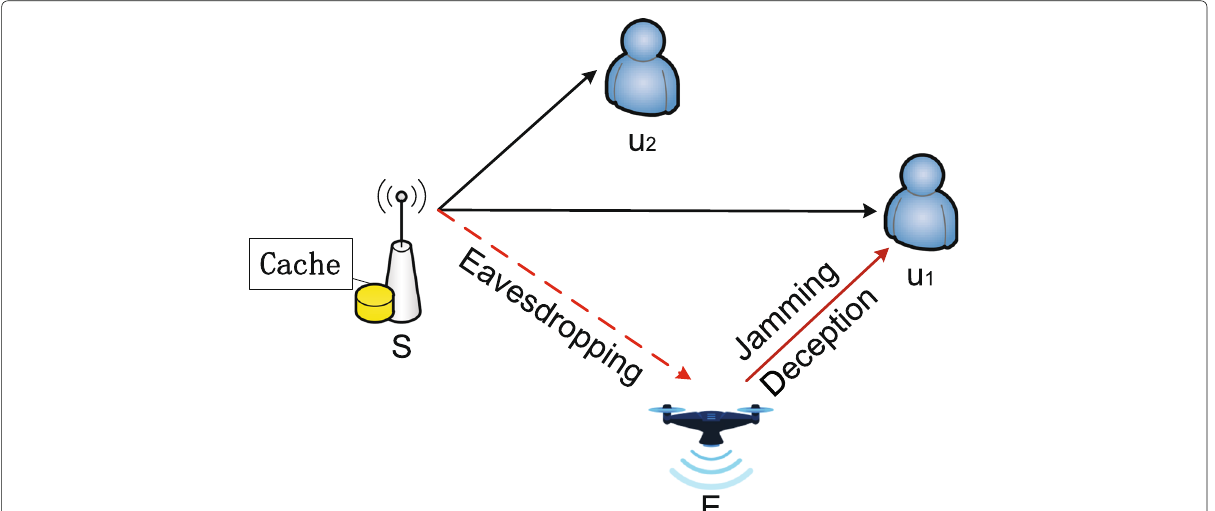
Fig. 1 Cache-assisted NOMA network of two users in different locations against intelligent attacks from